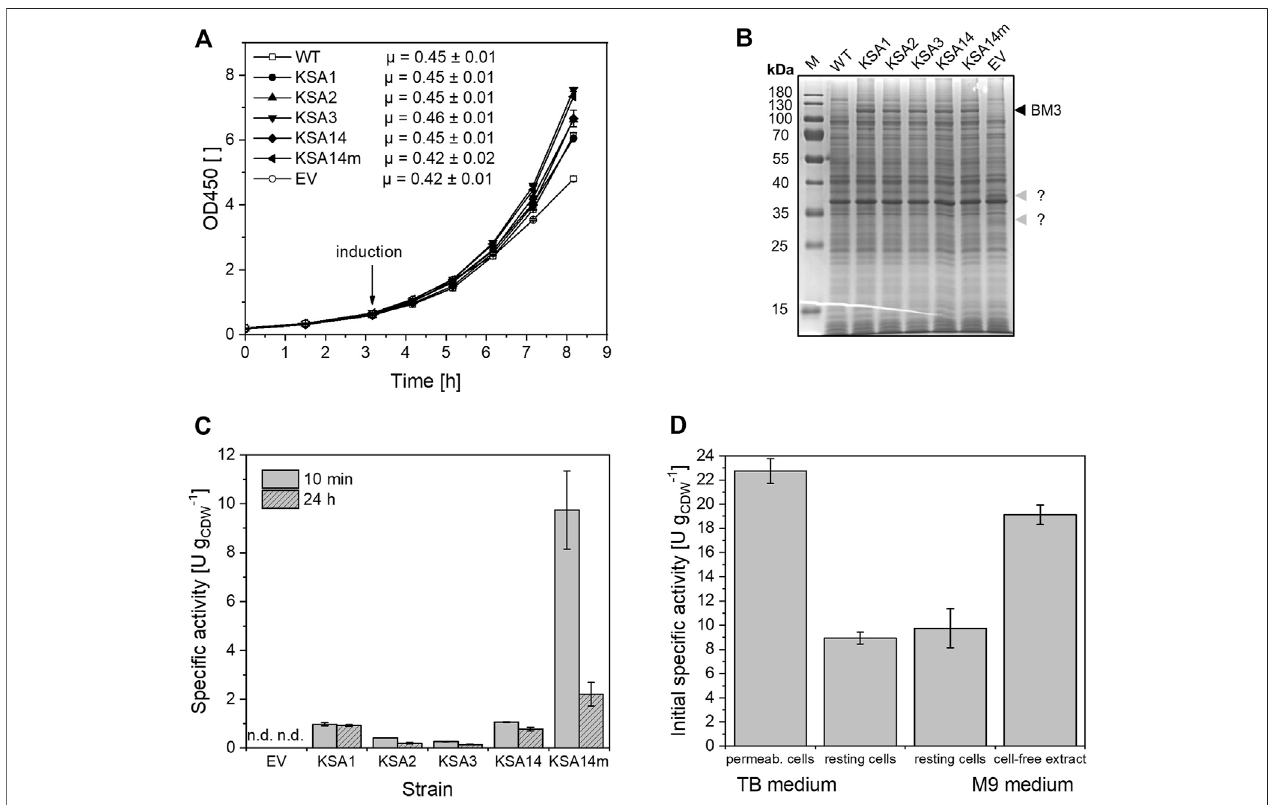
FIGURE 3 | Performance of E. coli BL21-Gold(DE3) strains carrying pETM11 with genes encoding the respective BM3 variants compared to the wildtype and an empty vectorcontrolstrainduringandaftercultivationinM9minimalmediumsupplementedwith0.5%(w/v)glucose. (A) BacterialgrowthinM9mediumuponinduction with0.1 mMIPTGandadditionof0.5 mM5-aminolevulinicacid. (B) SDS-PAGEanalysisofthedifferentstrains5 hafterinduction,withthebandat119 kDarepresenting therespectiveBM3variant(black arrow). Fortheempty vectorstrain,twounidenti fi edproteins (32and 38 kDa,greyarrows)wereobserved. (C) Initial(10 min)and long-term (24 h) testosterone hydroxylation activities of resting cells. (D) Activities of the KSA14m strain in different biocatalyst formats are compared. Activity assays were performed as described in the Materials and Methods section. The bars represent average values and standard deviations of two biological replicates (n.d., no product formation